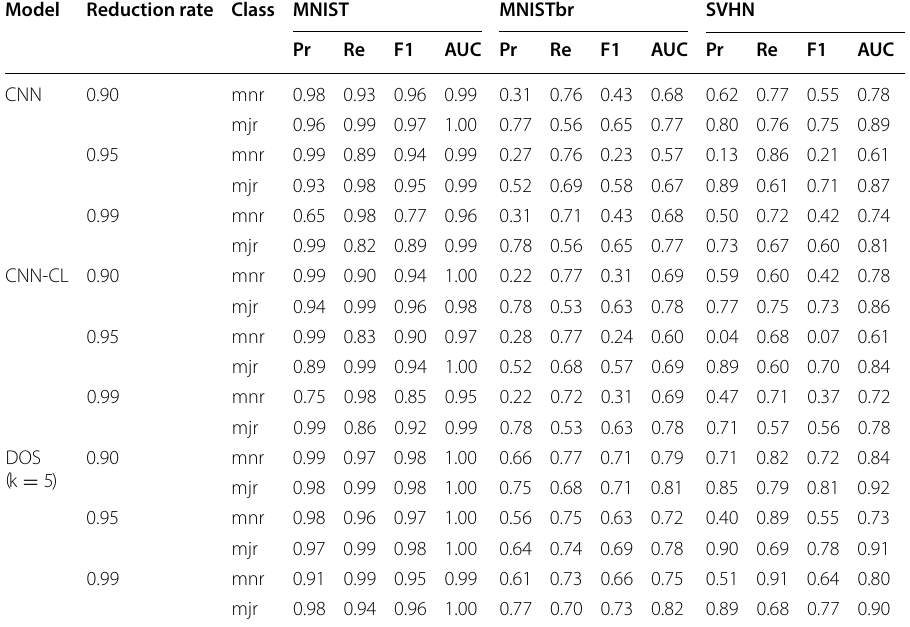
Table 14 DOS with varying imbalance [117] Model